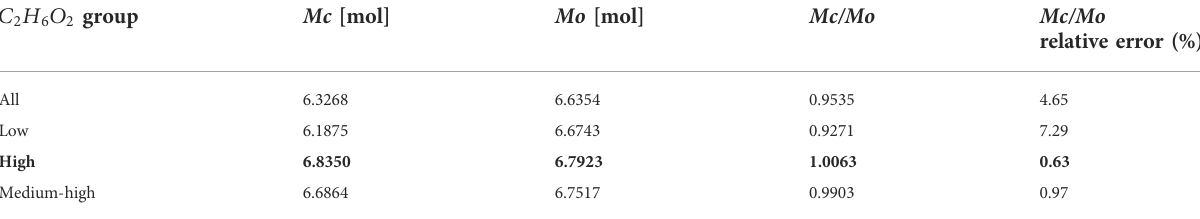
TABLE 7 Numeric solution of ethanediol.